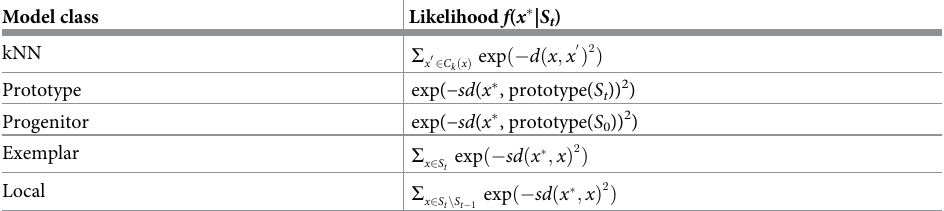
Table 1. Summary of model specifications. Each model specifies the likelihood of paper x � to appear at time t , given the existing set of papers S t . d denotes Euclidean distance. C k ( x ) � S t denotes the k closest points to x